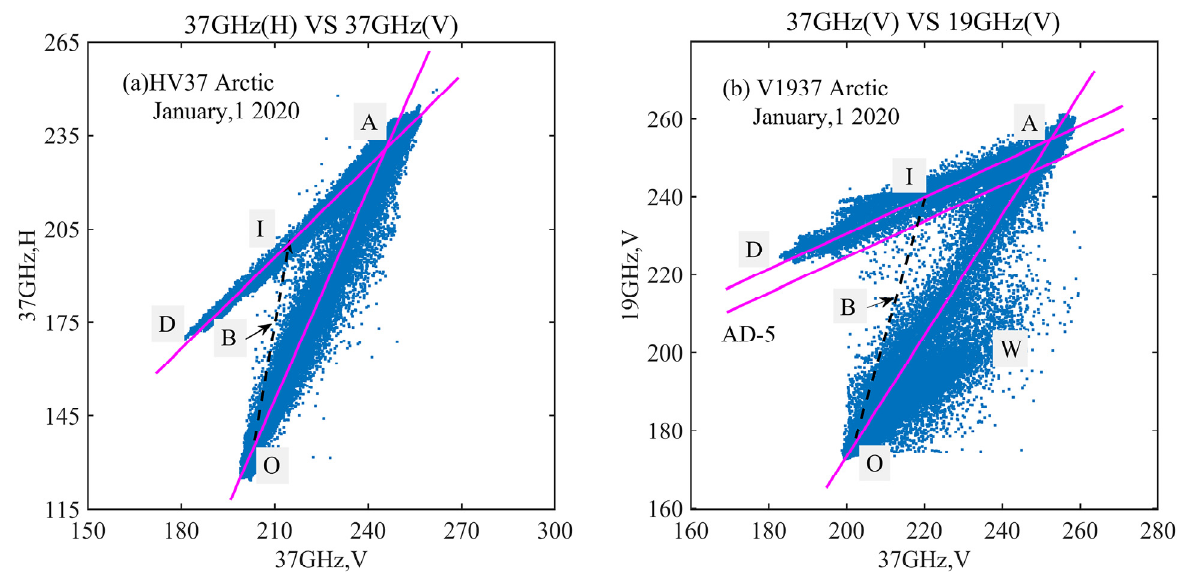
Figure 3. Scatter diagrams of polarization mode and frequency mode on 1 January 2020. ( a ) Polari- zation mode. ( b ) Frequency mode. AD line for sea ice close to 100% SIC, the letter I indicates differ- ent types of ice, the letter B indicates the SIC value at any point, the letter O indicates water tie-